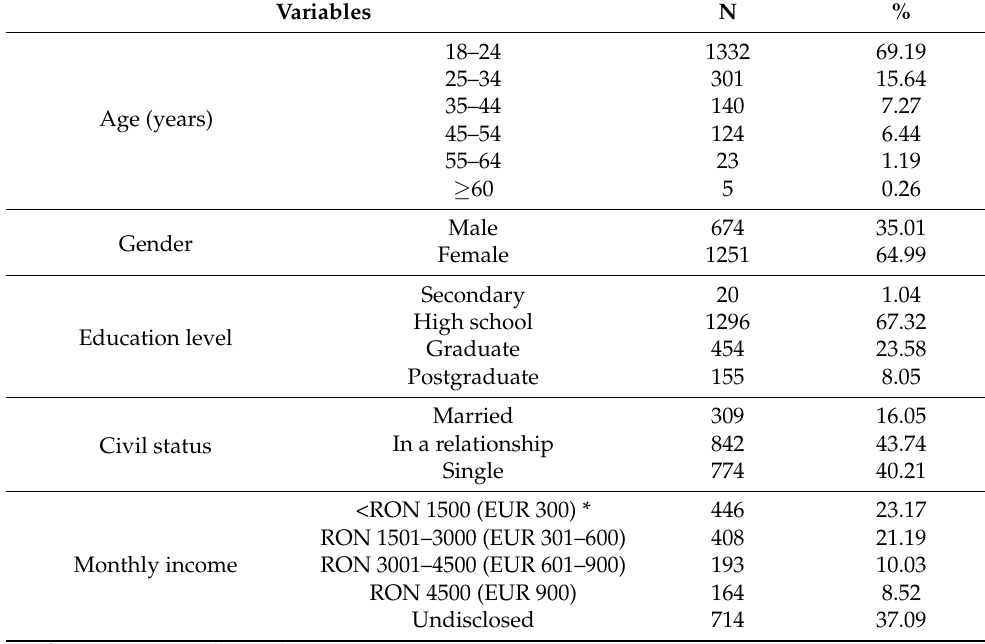
Table 1. Demographic characteristics of the